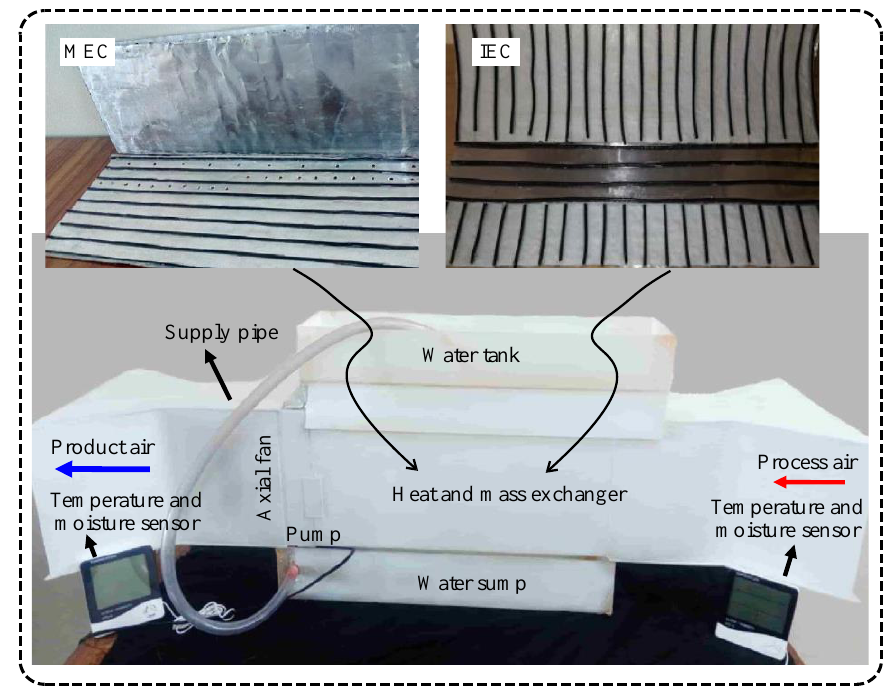
Figure 3. A pictorial representation of the experimental apparatus for MEC and IEC EC systems.